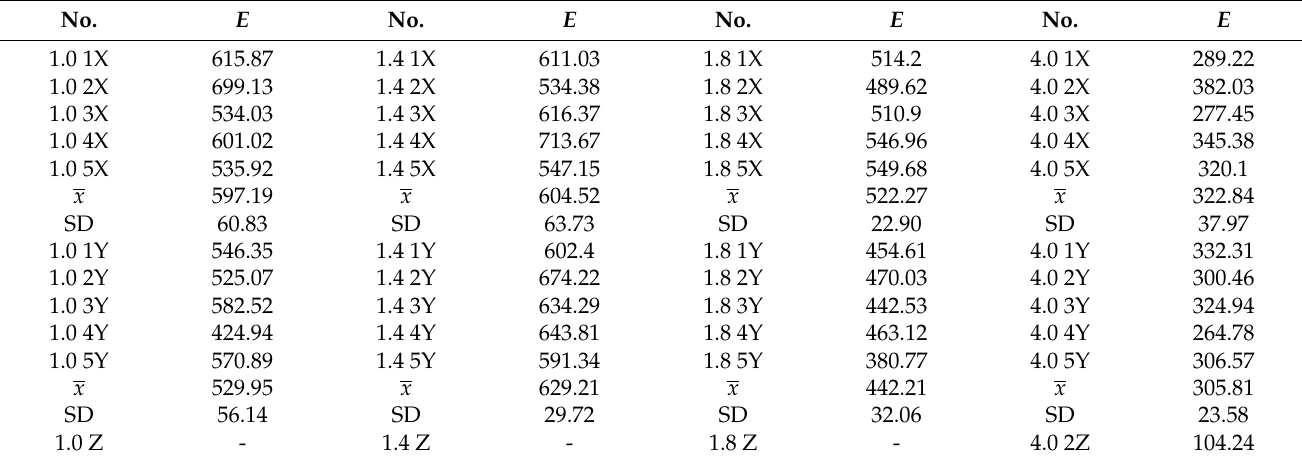
Table 4. Modulus of elasticity (in MPa) obtained for the PLA + bronze specimens.